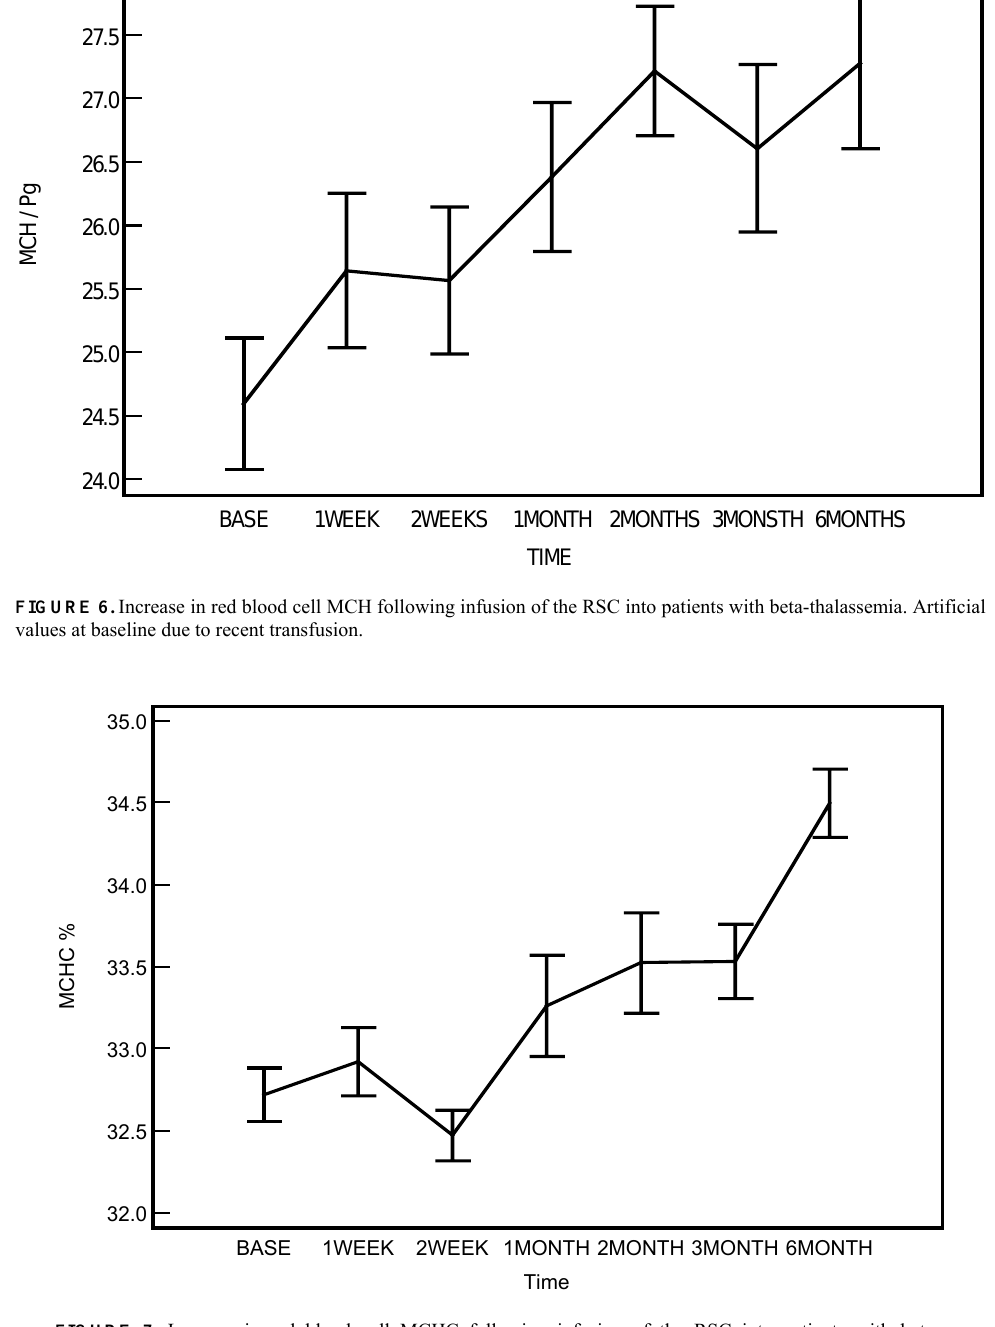
was accompanied by gradual decrease in MCV and MCH (from 72 fl and 23.1 Pg at baseline to 55.9 fl and 18.2 Pg, respectively, at 6 months), but not mean MCHC (patient 18). The decrease in MCV and MCH in this patient was mainly due to a significant increase in the number of red blood cells with much higher Hb E content Moreover, this patient who used to receive 3.5 units/90 days of packed red blood cell prior